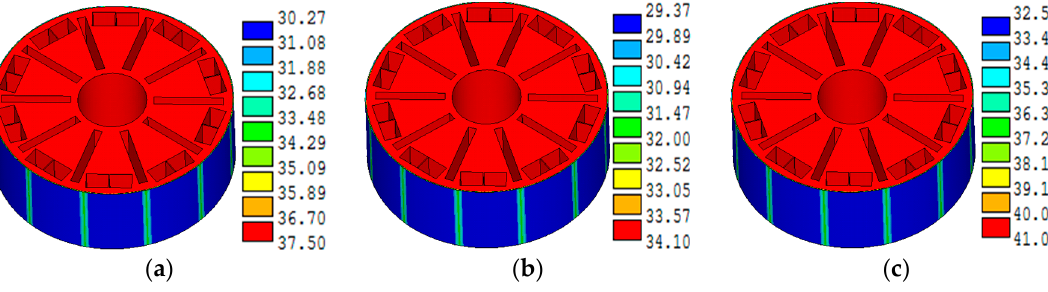
Figure 17. Temperature distribution of the rotor core (°C); ( a ) 0 At AMMF; ( b ) 600 At AMMF; and, ( c ) 900 At AMMF.